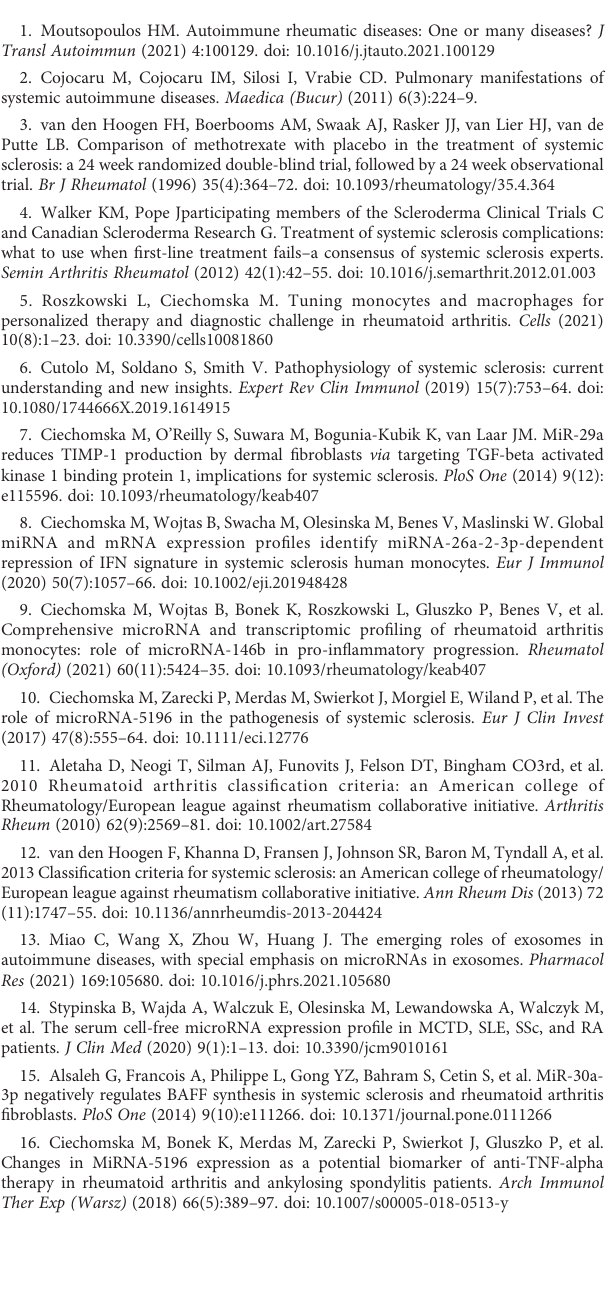
SUPPLEMENTARY FIGURE 1 Enrichment analysis of 6 selected miRNA and predicted their target genes which are involved in immune pathways dysfunction both in RA and SSc monocytes.